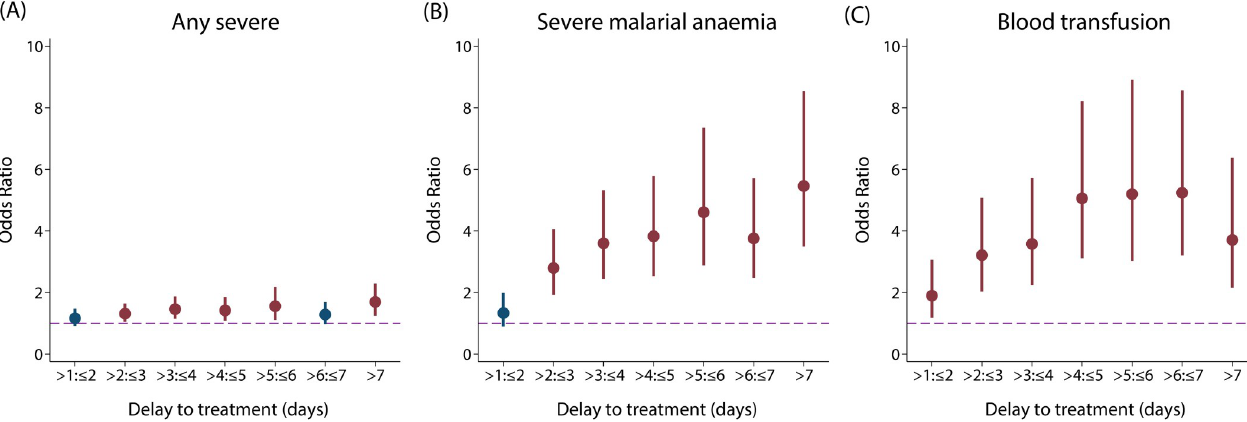
Fig 3. Treatment delay and odds of presenting with any SM (A), SMA (B), and receiving blood transfusion (C) in children under 15. ORs (and 95% CIs) for presentation with severe disease rather than UM (A & B) with each additional reported day of delay after initial symptoms, compared with patients receiving treatment within 1 day of symptom onset (N UM = 3,277, N SM = 3,708, N SMA = 1,774). Amongst 5 studies with information on blood transfusions during hospital admission, 27.7% (1,520/5,496) of children aged under 15 with available data had received a blood transfusion. ORs (and 95% CIs) for receiving a blood transfusion was estimated for each additional day of illness duration amongst all uncomplicated and severe cases. All ORs shown were obtained from a mixed-effects logistic regression adjusted for age as a linear predictor and allowed for random study effects. Statistically significant ORs are denoted in red (dashed purple line: OR = 1). OR, odds ratio; SM, severe malaria; SMA, severe malarial anaemia; UM, uncomplicated